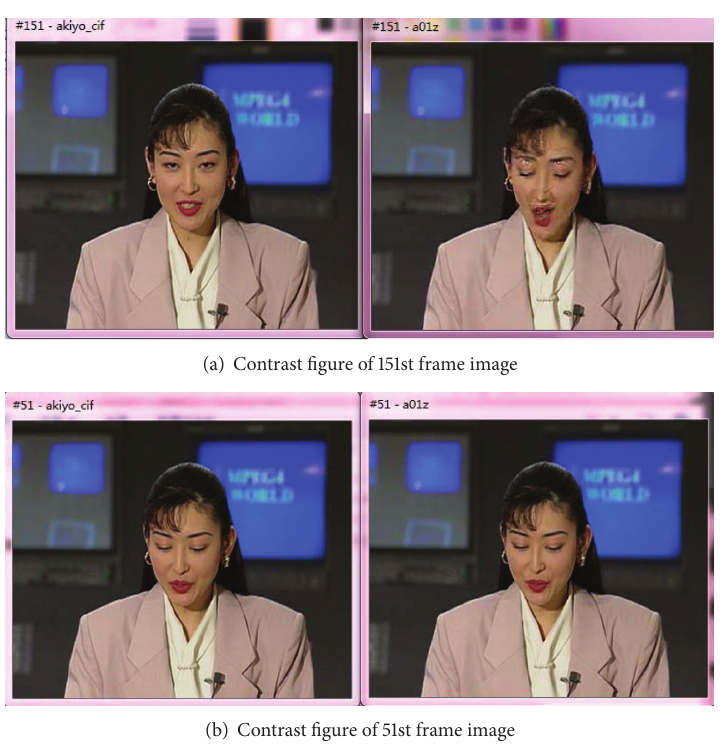
Figure 3: Contrast figure of original image and reconstruction image.